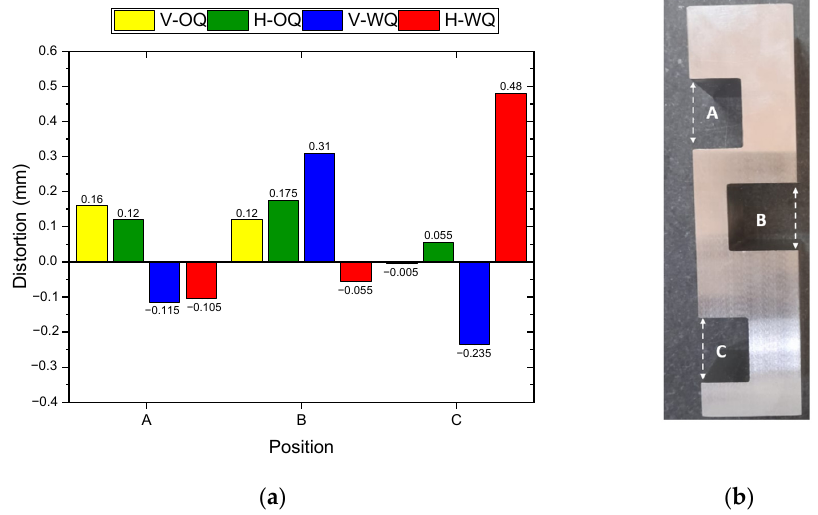
Figure 13. ( a ) Measured distortion after quench and ( b ) measured gaps in geometry. It can be seen that the major distortion was presented in the water-quenched samples in the direction of horizontal immersion (H-WQ), and the magnitude of the measured distortion was ≈ 0.48 mm, while the minor distortion was found for the case of the oil- quenchied samples and when the piece enters the quenching media in a vertical direction (V-OQ), with a magnitude of just |0.005| mm. In both cases, these values occurred in the thinnest region of the piece, identified as zone C. Furthermore, it was observed that for the quench in water and in the direction of the vertical immersion (V-WQ), a distortion was obtained in the range of 0.23–0.31 mm for the gaps B and C, while for A it corresponded to the thickest region of the piece and presented the lowest distortion levels, regardless the cooling media used. In a general way, the tendency to increase the magnitude of the distortion was presented when using the direction of horizontal immersion and using water as the quenching medium, while when using oil, which is the less severe quenching medium, and a vertical direction immersion, the decrease of the distortion effect is favored.